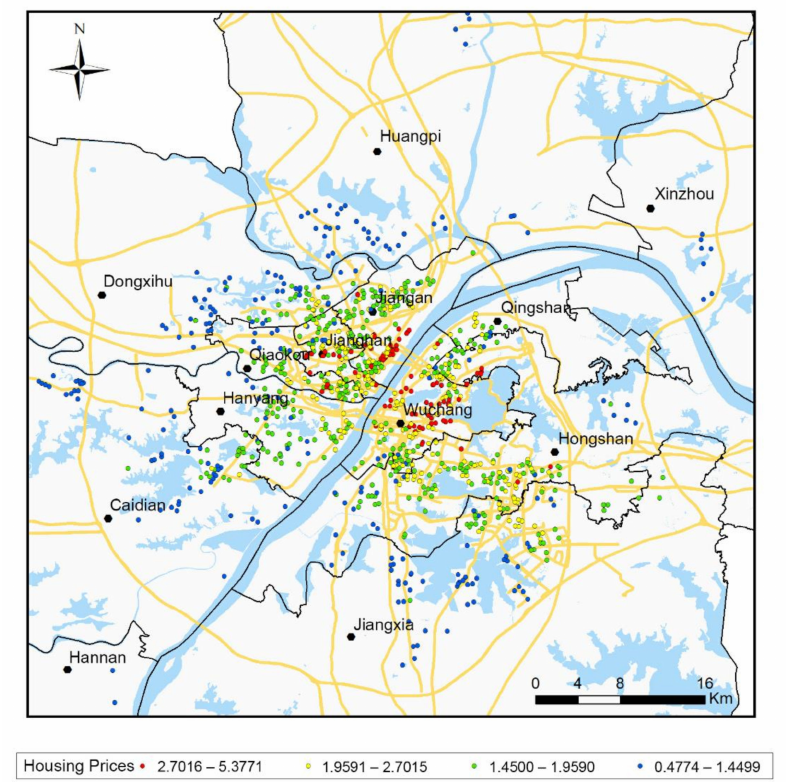
Figure 5. Price of commercial housing in